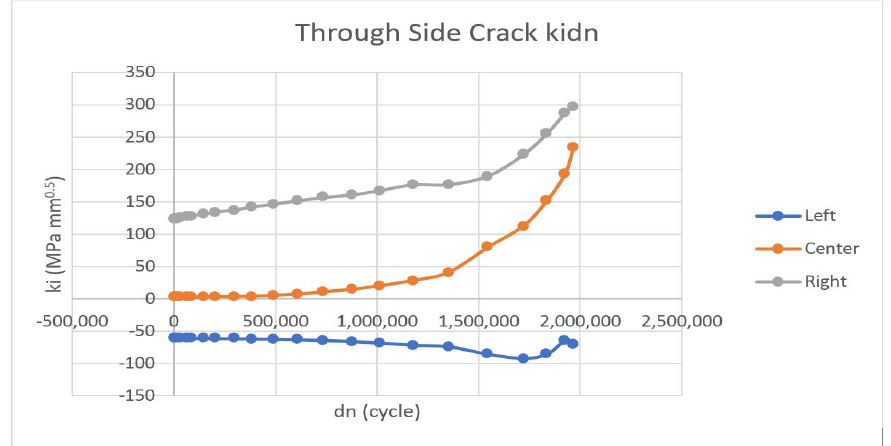
Figure 18. Cycle vs. stress intensity factor for through side crack.